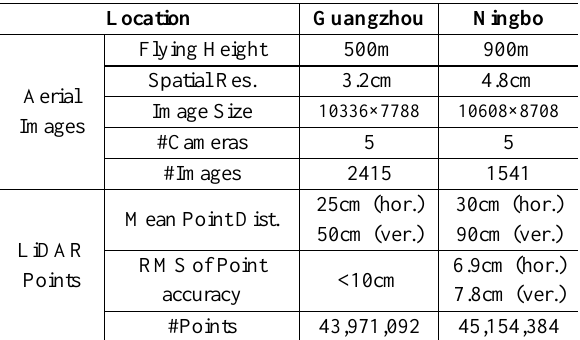
Table 1. Detailed information of the test data